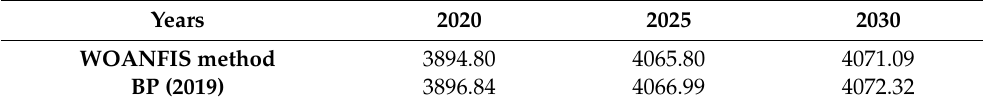
Table 4. A comparison of projections of global coal consumption [Mtoe] for the years (2020–2030).